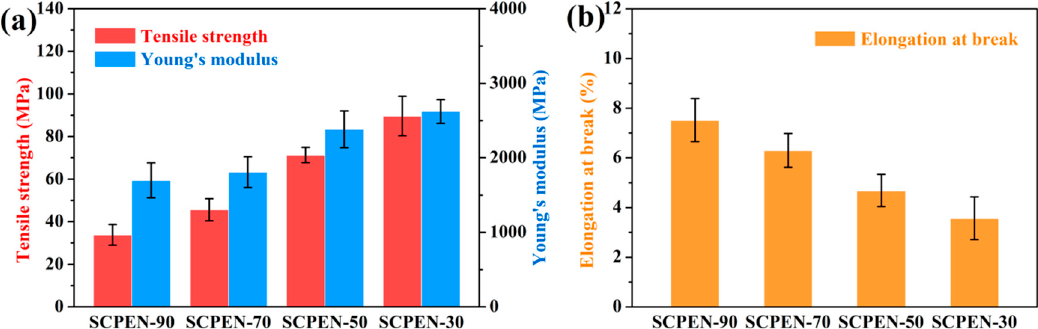
Figure 5. Mechanical properties of SCPEN films: ( a ) tensile strength and Young’s modulus; ( b ) elongation at break.